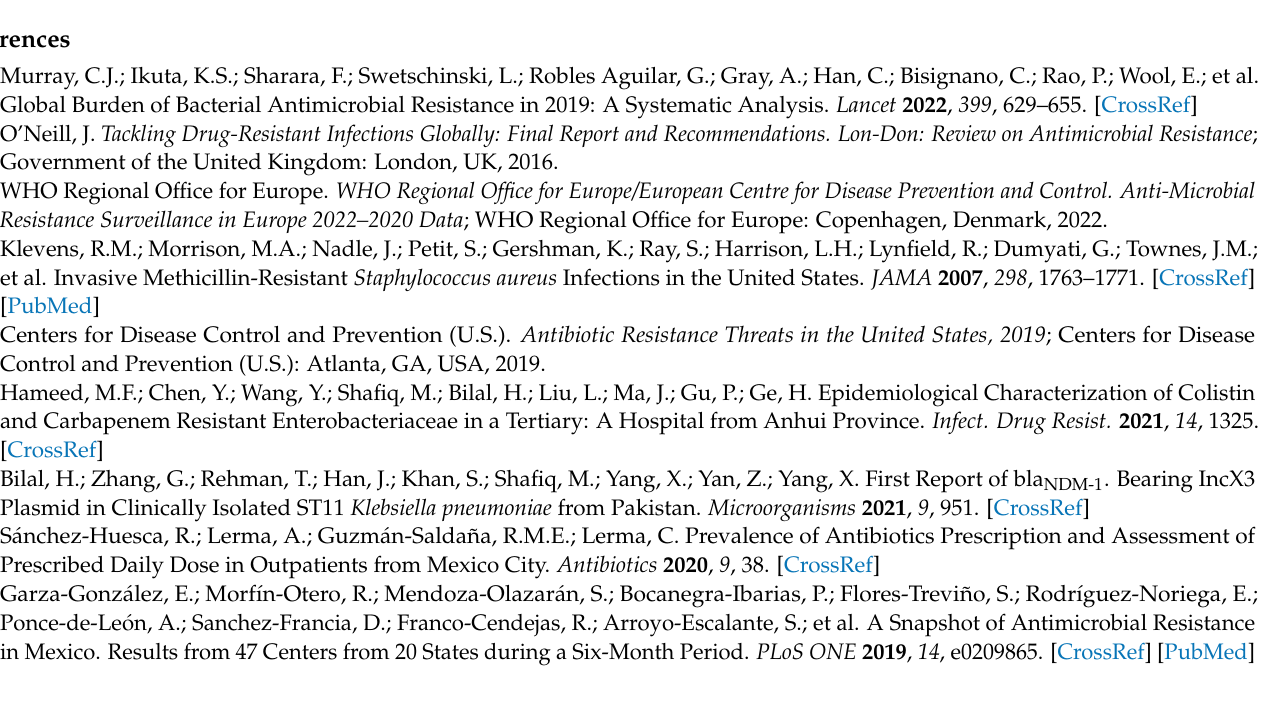
cioeconomic questionnaire, Table S2: List of antimicrobial resistance genes miDOG, Table S3: Species that have a beneficial role for the host, Table S4: AMR genes detected in adolescent fecal samples and Table S5: Presence of resistance genes in E . coli and K . oxytoca DNA from adolescent fecal